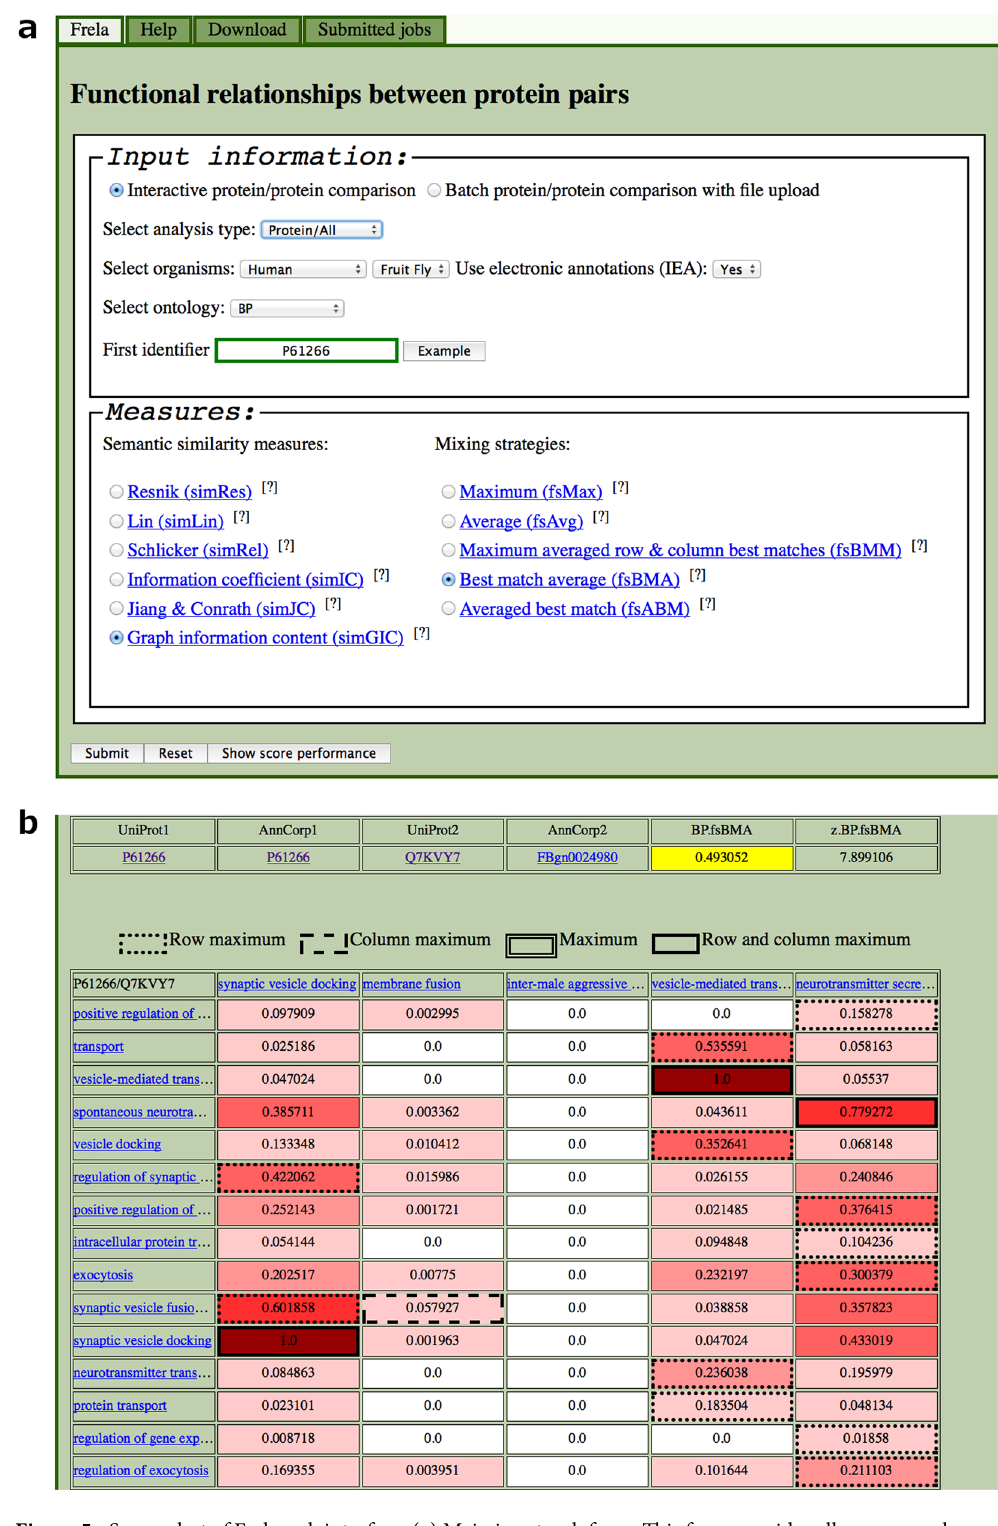
Figure 5. Screenshot of Frela web interface. ( a ) Main input web form. This form provides all necessary elements to run a protein functional similarity calculation with Frela. The user can choose between manual data entry (interactive protein-protein comparison) and file upload (batch mode). We support computation of pairwise protein functional similarities for any organism or a scan of a single protein versus all annotated human, fly, or mouse proteins. In addition, it is possible to specify use of either the IEA ( + ) or the IEA ( − ) dataset with the “Use electronic annotations (IEA)” option. In this panel we show the parameters used in the example given in the “Web Server” section, which is a scan of the human STX1B protein (UPANr P61266) versus all annotated proteins from the fly BP ontology, calculating simGIC / fsBMA scores and including IEA evidence codes. ( b